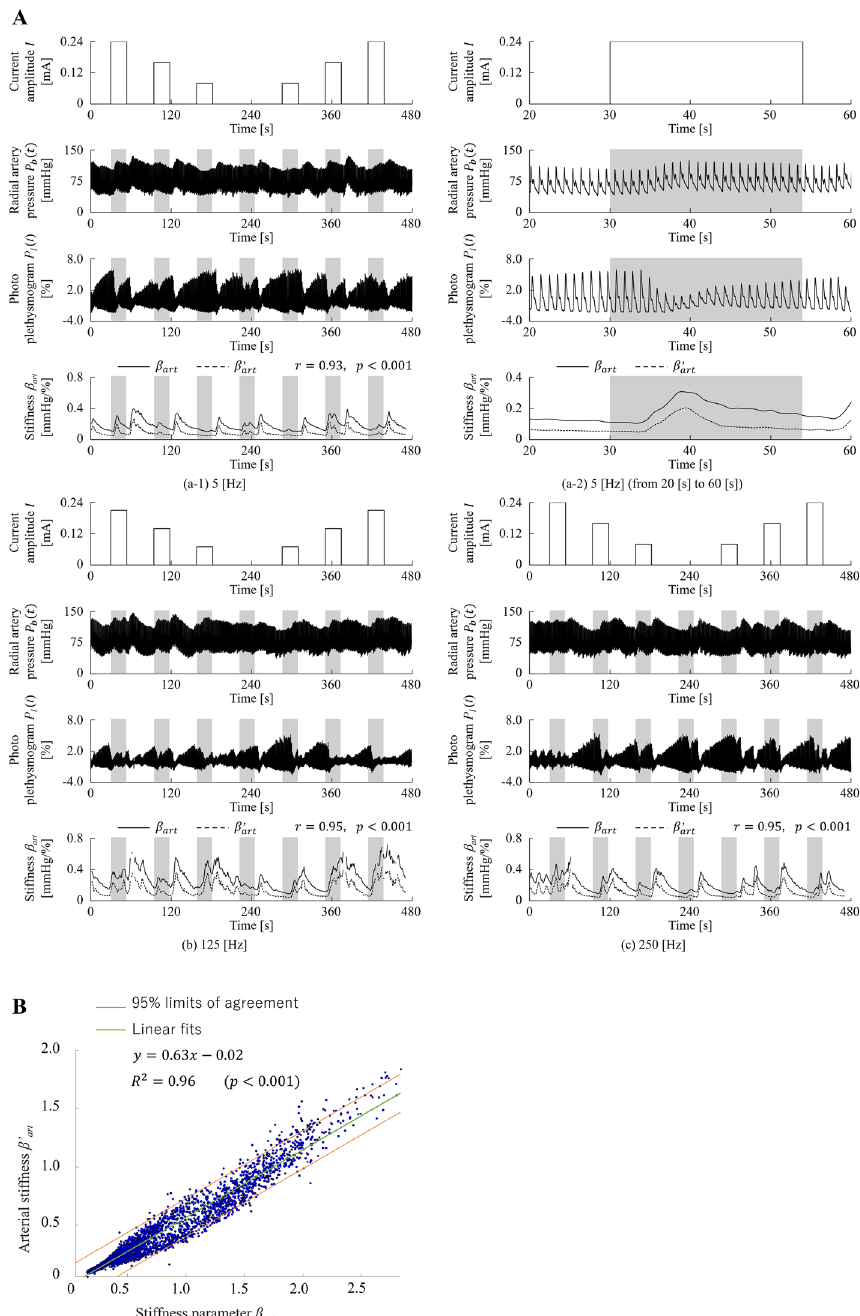
Figure 4. Verification of the estimation accuracy of the peripheral arterial stiffness of the proposed model. ( A ) From top to bottom, this panel shows amplitudes of electrocutaneous stimulations, radial arterial pressures, photo-plethysmography, stiffness parameter estimates ( β art ), and peripheral arterial stiffness ( β from Participant A. (a-1) and (a-2) show the measured results at a frequency of 5 Hz; (a-2) enlarges the time duration of the first trial from 20 to 60 s; (b) and (c) show the measured results at 125 Hz and 250 Hz, respectively. ( B ) Shows a comparison of the peripheral arterial stiffnesses β art and β the proposed model and the previous model,